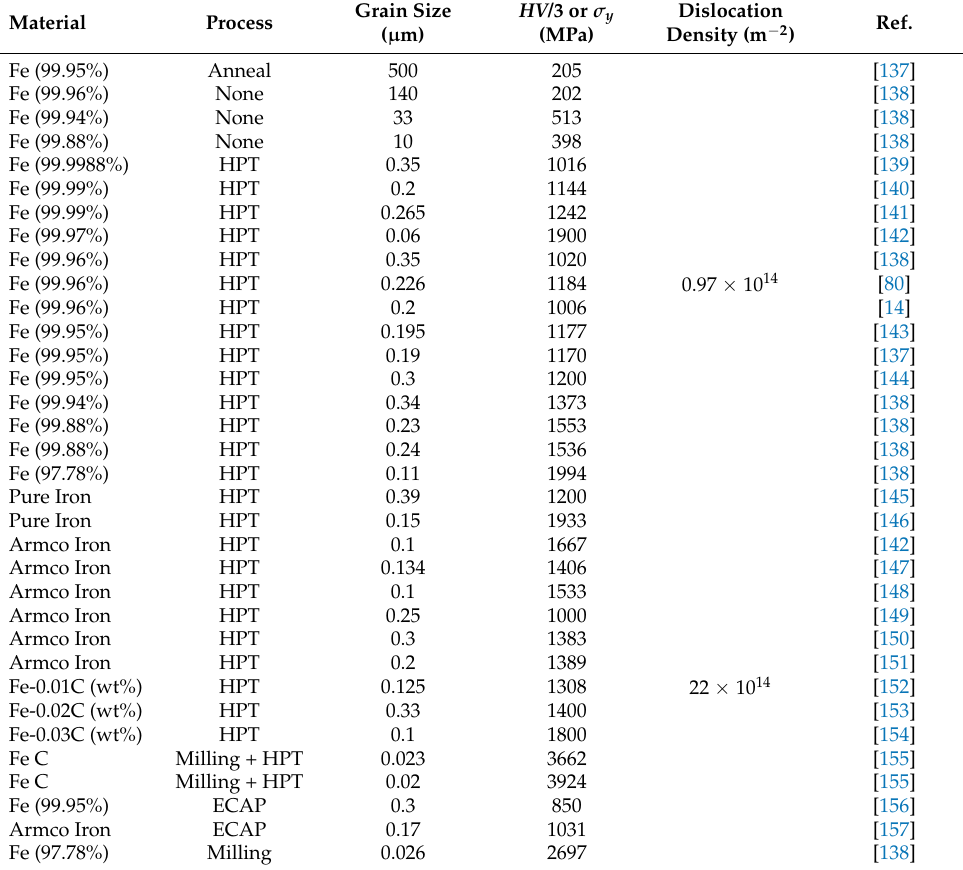
Table A4. Reported experimental data for grain size, yield strength or hardness divided by three, and dislocation density for iron before and after processing by severe plastic